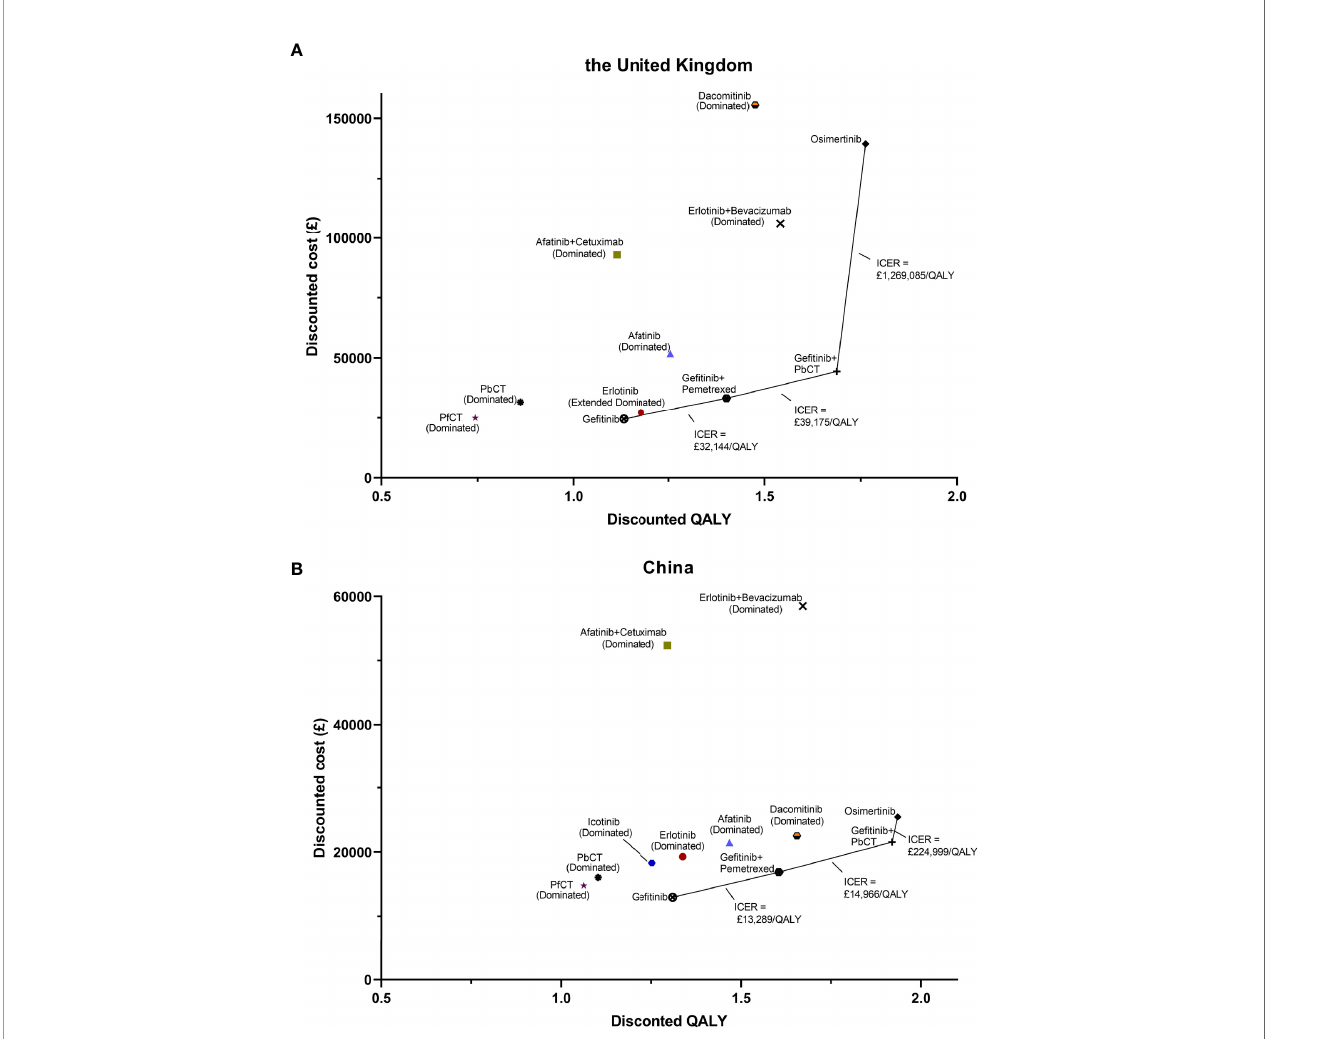
FIGURE 1 | Cost-effective frontier of the 12 fi rst-line treatments for patients with advanced epidermal growth factor receptor mutated non-small lung cancer in the UK setting (A) and the Chinese setting (B) . (PfCT, pemetrexed free chemotherapy; PbCT, pemetrexed based chemotherapy; QALY, quality-adjusted life